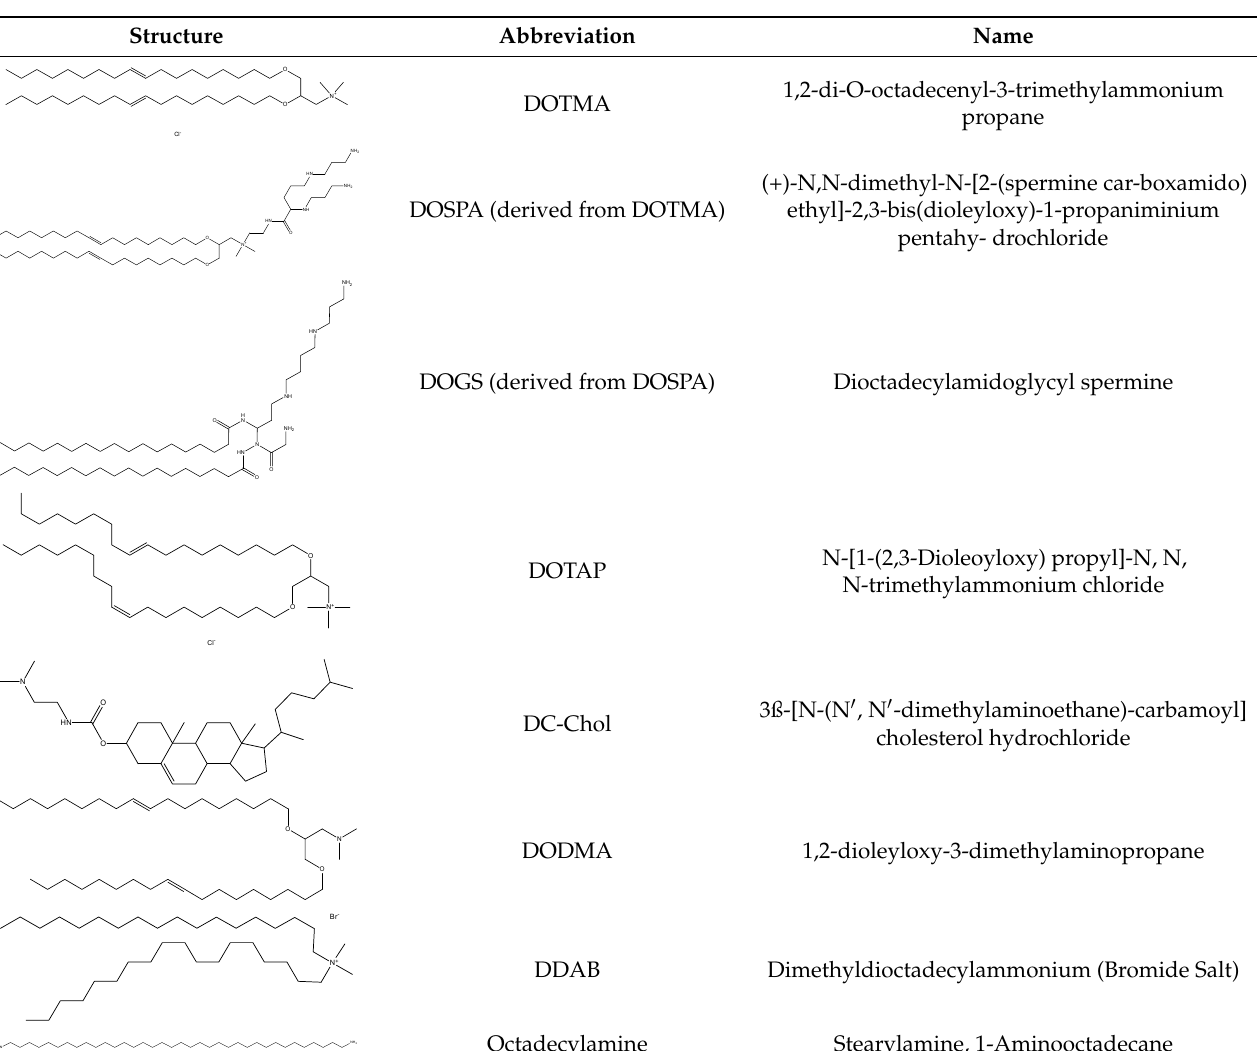
Table 5. Types of common cationic lipids used in formulating cationic liposomes. Structure